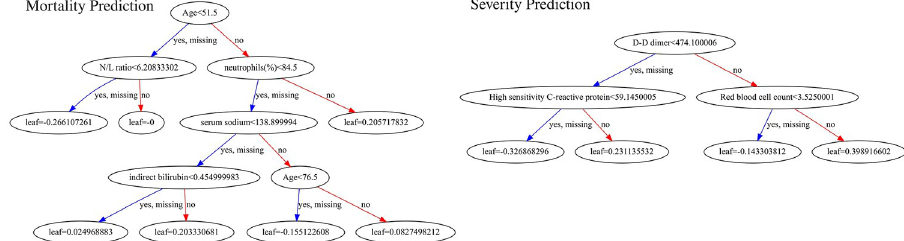
Fig 5. Sample decision trees of mortality (left) and severity (right) prediction models to test clinical applicability.